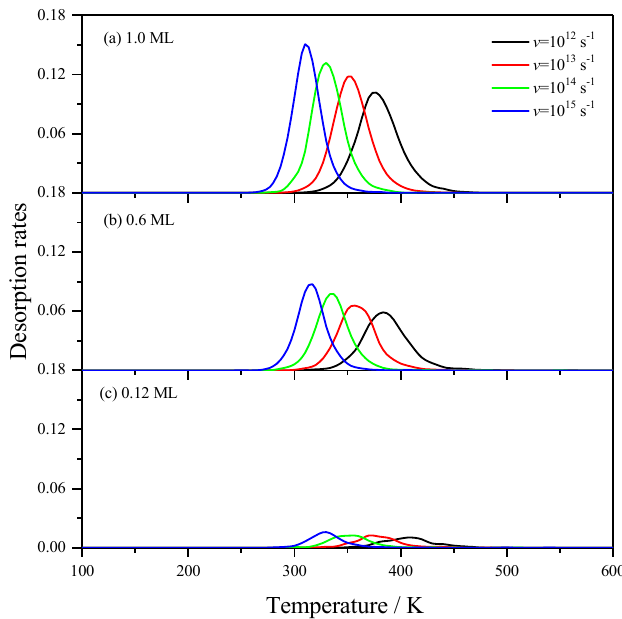
Figure 4. Effects of the pre-exponential factors on the H 2 TDS spectra. E a = 22 kcal/mol, E int = 0 kcal/mol.